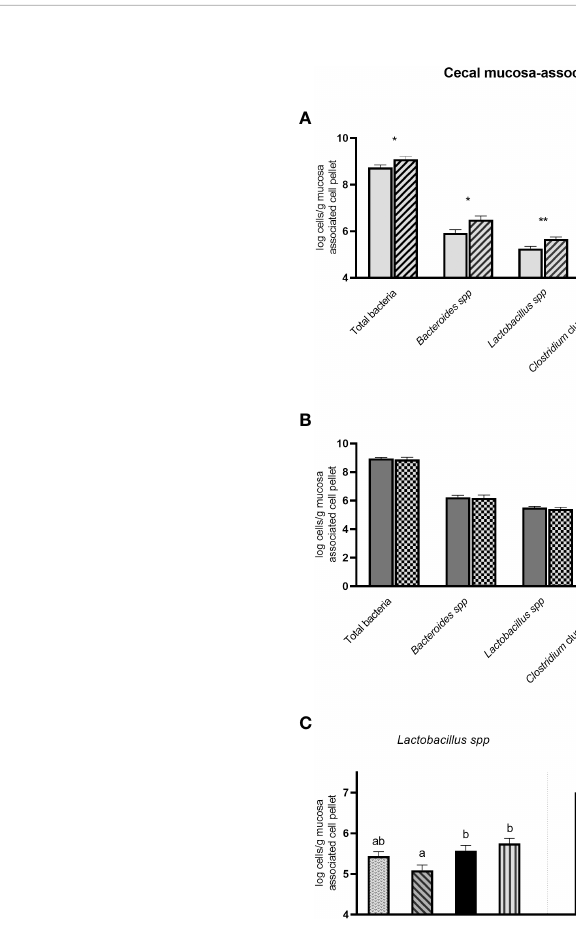
FIGURE 1 Effect of diet speci fi cations (A) and phytogenic inclusion (B) and interaction effect of diet speci fi cations × phytogenic inclusion (C) in cecal mucosa-associated bacteria of 42-day-old broilers. Columns indicate means + SE and the asterisks denote level of statistical difference *P ≤ 0.05, **P ≤ 0.01. Treatment means with different superscripts a, b differ signi fi cantly (P <